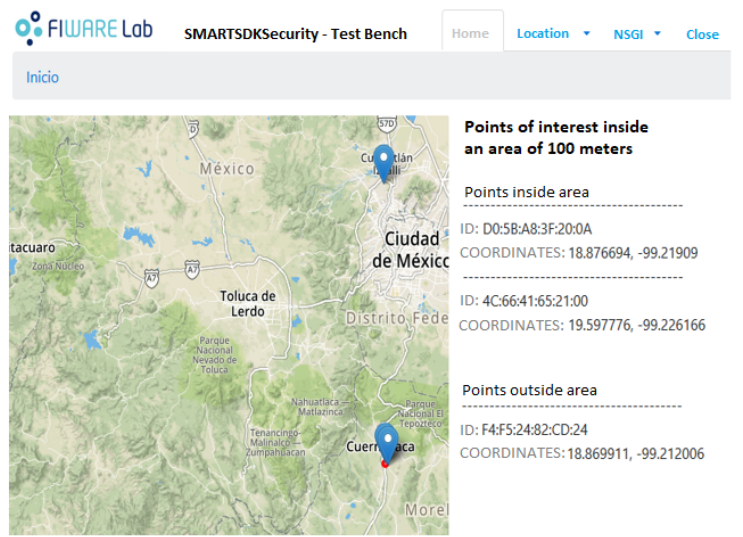
Figure 8 Example of a Geolocation application.